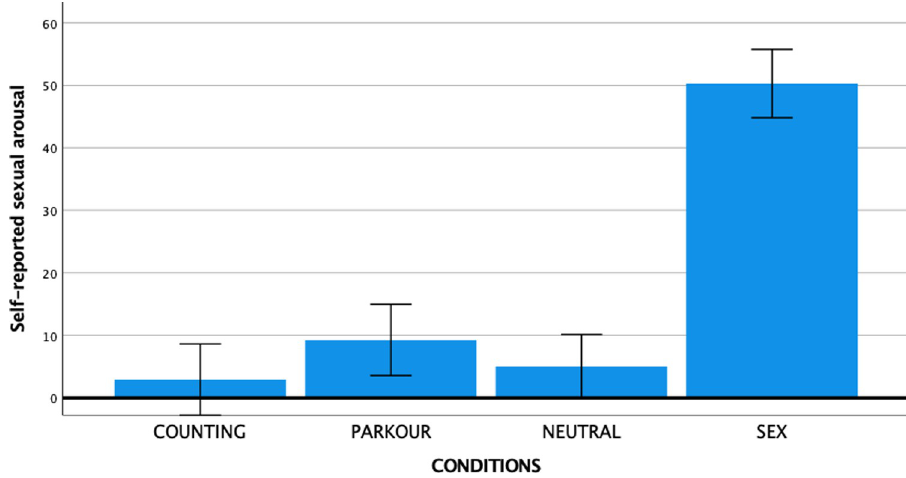
Fig 2. Mean self-reported sexual arousal levels per condition with error bars representing 95% confidence